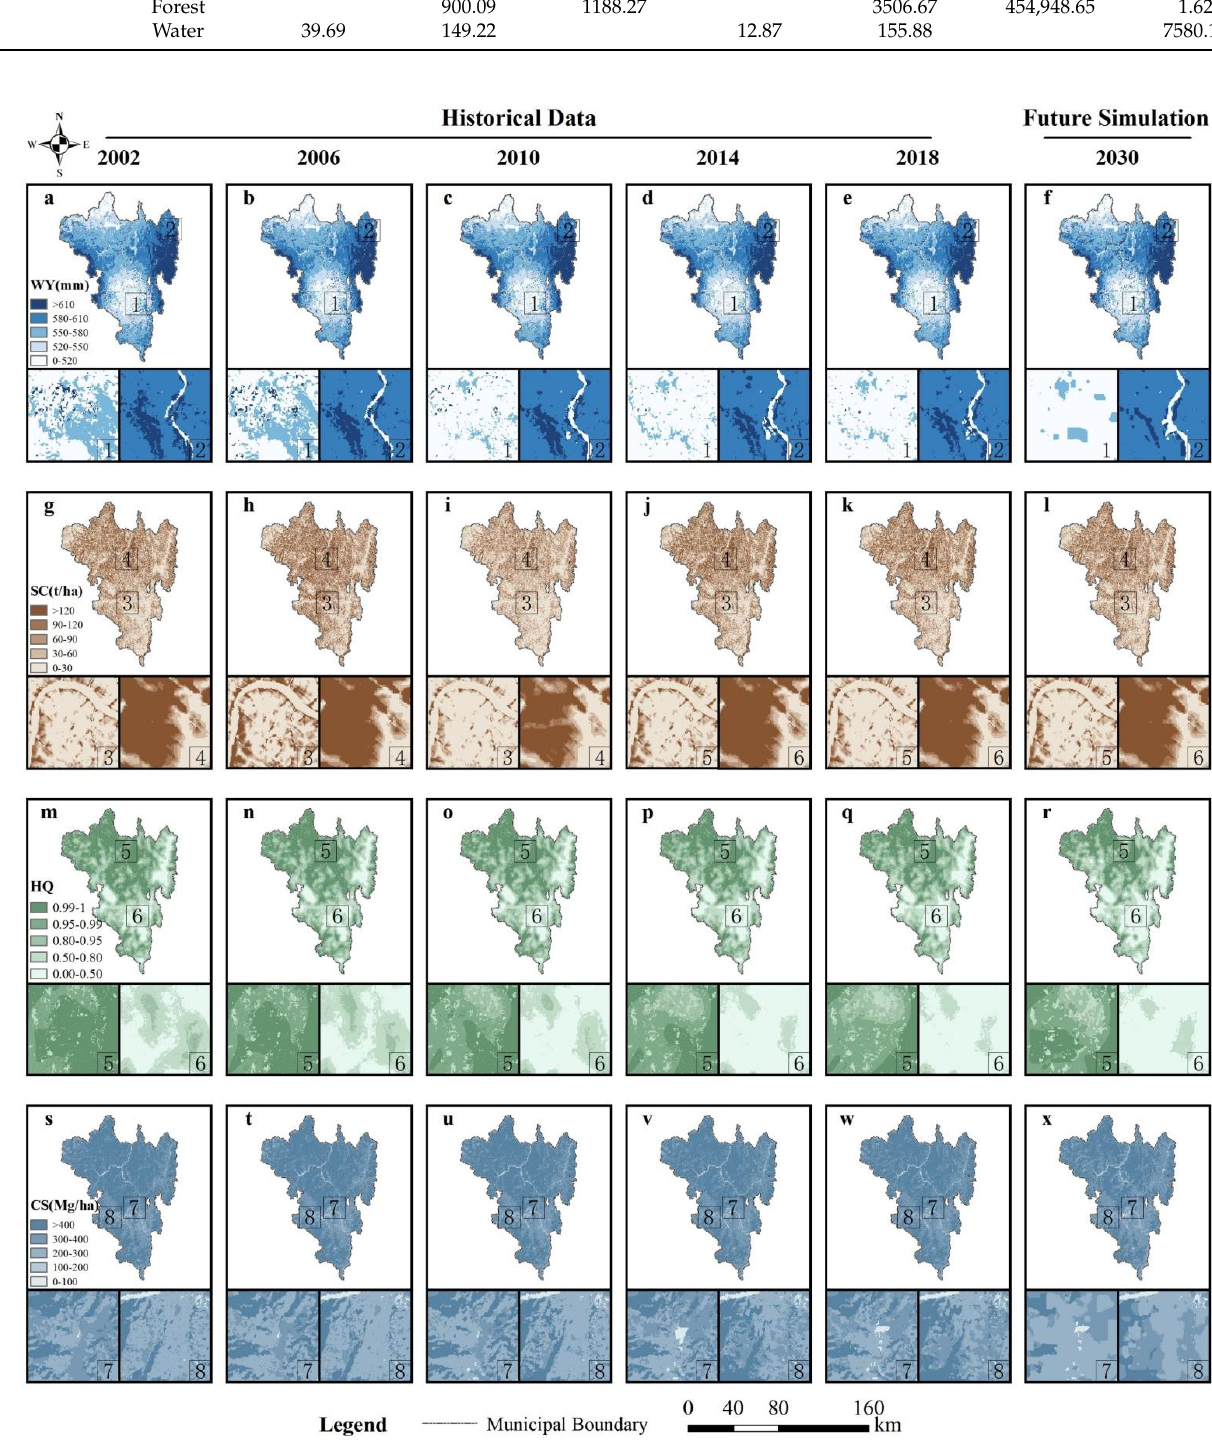
Figure A1. ( a – x ) Spatial and temporal distribution of ecosystem services from 2002 to 2030.